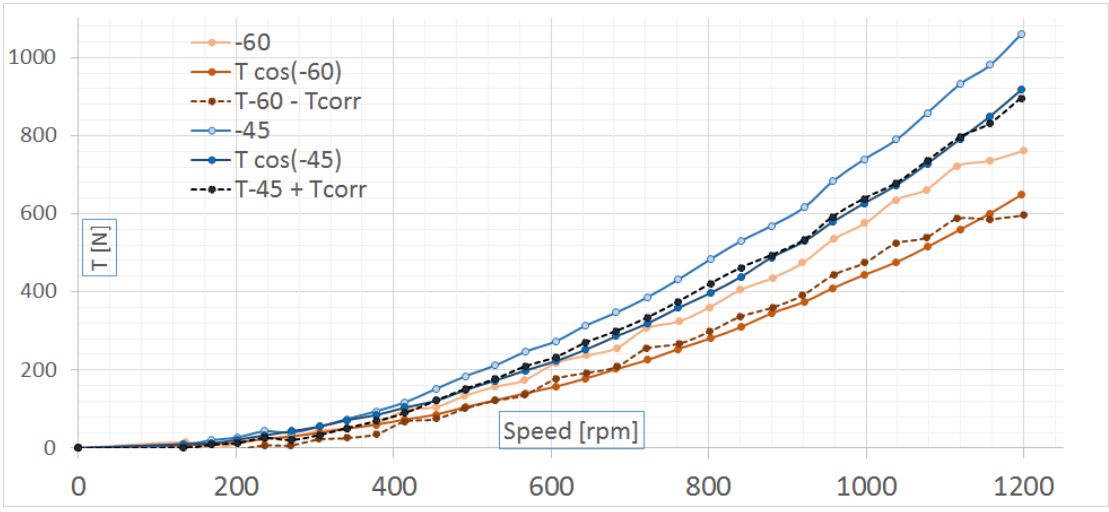
Figure 25. The application of angle correction.